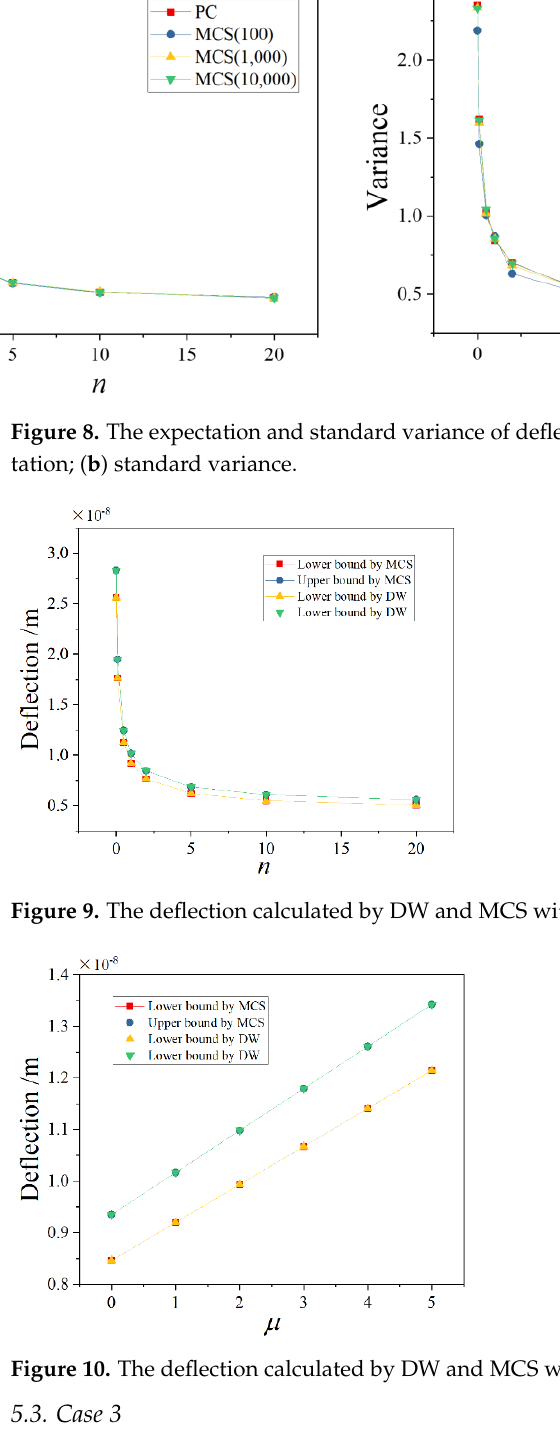
Figure 9. The deflection calculated by DW and MCS with different n .